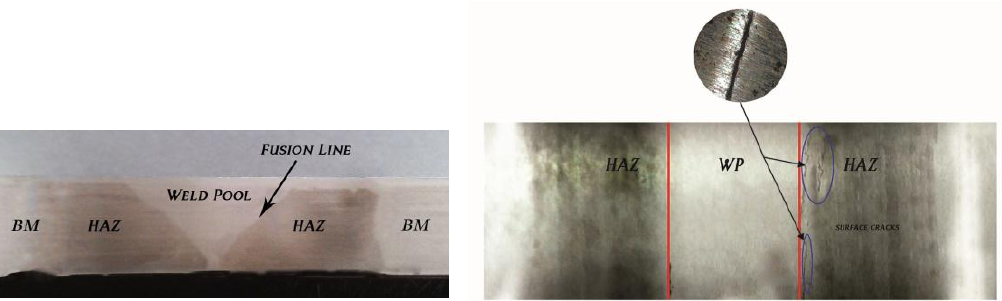
Figure 7. The effect of the shielded metal arc welding on the Heat Affected Zone (HAZ) area and surface crack formation after the welding process for AISI 1045.